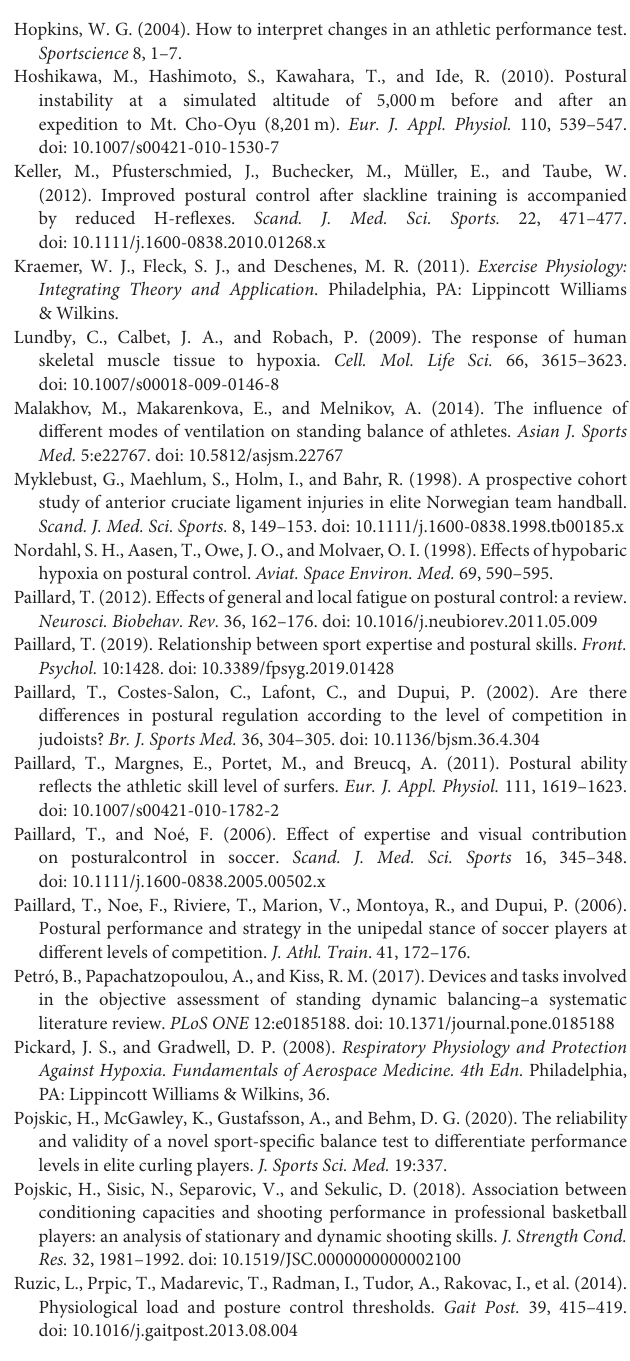
Supplementary Figure 1 | Acute effects of normobaric hypoxia on oxygen saturation (SpO 2 ) and heart rate response (HR). T 1 − 3 , trials 1–3 of the single-leg